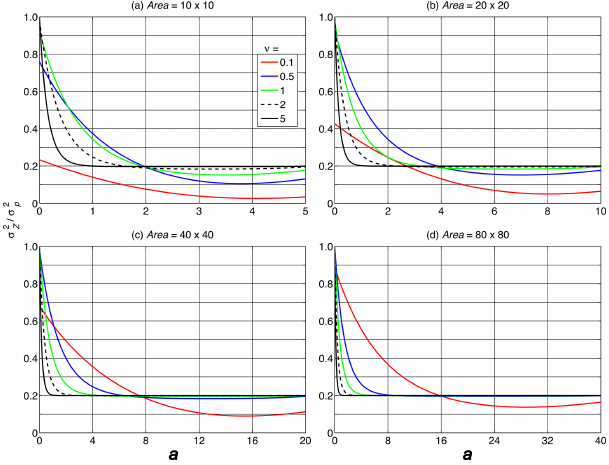
Figure 14. Theoretical normalized squared error ( σ 2 function of the distance a from the center of the area for square areas of side dimensions ( L ) between 10 and 80. Each curve corresponds to an exponential decay ( ν ) between 0.1 and 5.